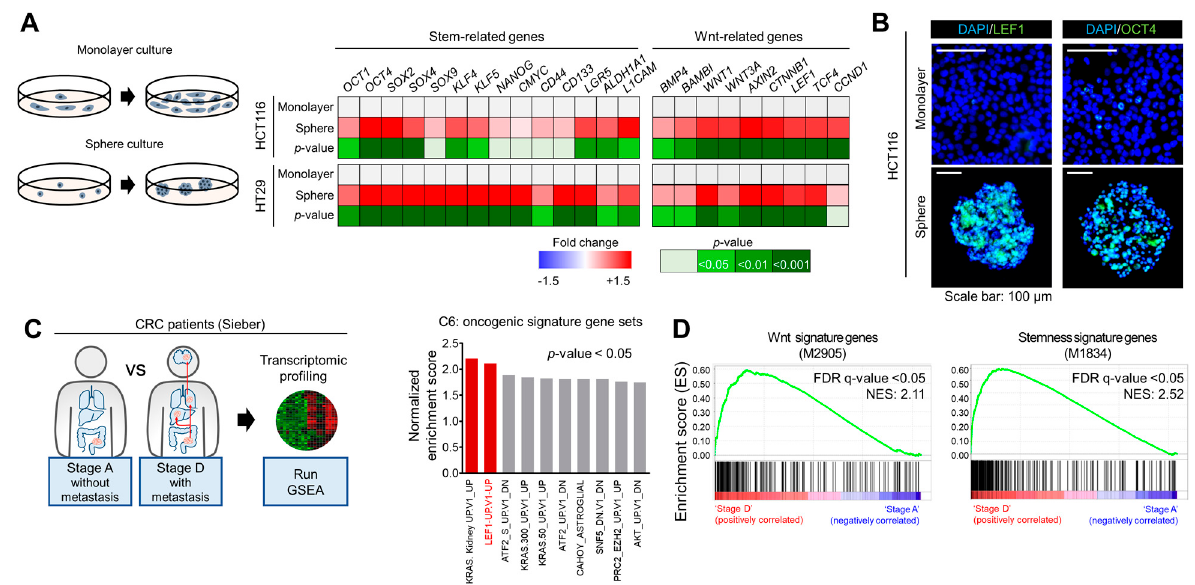
Figure 1. Relevance of Wnt activation and stemness to CRC metastasis. ( A ) RT − qPCR comparing the global trends in stemness- and Wnt-related gene expression between spheres and monolayer bulk cells. The data are presented as a heatmap with fold changes and p − values. ( B ) Immunofluorescence assay confirming the increased LEF1 and OCT4 protein levels in spheres. ( C ) Scheme for GSEA comparing Dukes’ stage A and D tumors from CRC patients. Top 10 oncogenic signature gene sets enriched in Dukes’ stage D CRC. ( D ) GSEA enrichment plots of Wnt signature genes ( left ) and stemness signature genes ( right ).